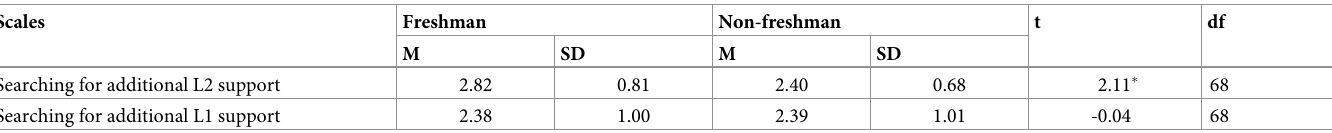
Table 9. Descriptive statistics and t -test results for science learning strategies (freshmen vs. non-freshmen). Scales